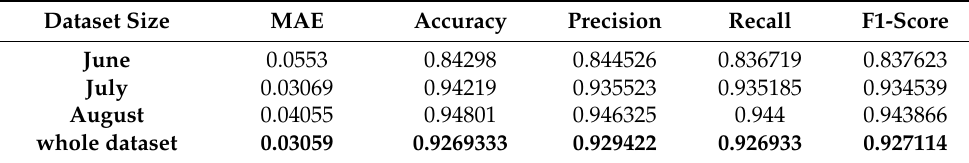
Table 5. MAE, accuracy, precision, recall, and F1-score.